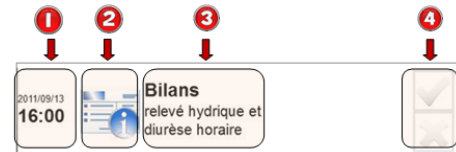
Figure 10. Indexicality indicators of every intervention